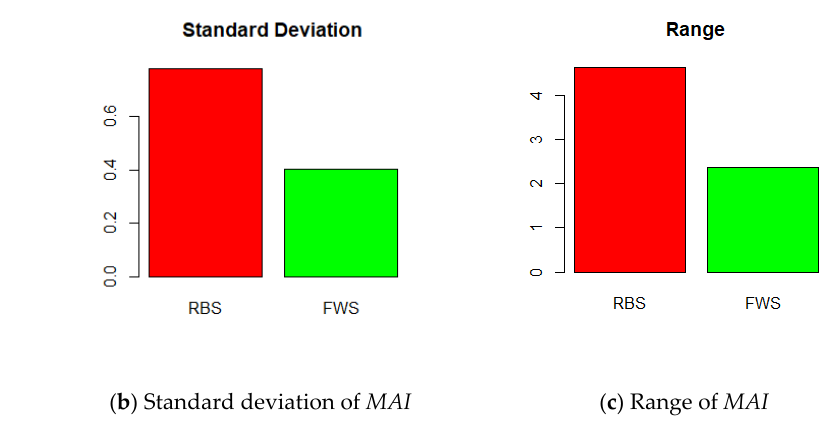
Figure 10. Comparison of RBS and FWS. 301